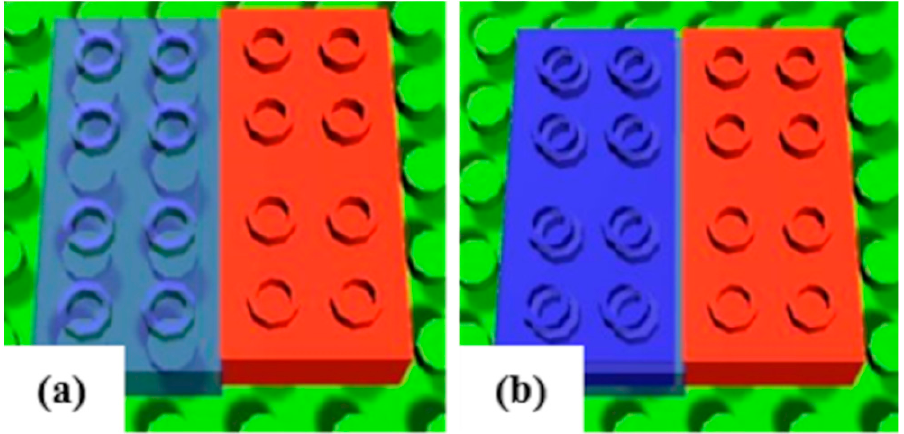
Figure 1. Visual realism in the DSTE: ( a ) the blue LEGO brick, which simulates the real one, is rendered in “opaque” mode, whereas the red product model used as a visual asset is rendered in “transparent” mode; ( b ) the misalignment between the simulated real brick and the corresponding visual asset to reproduce the effect of registration error.